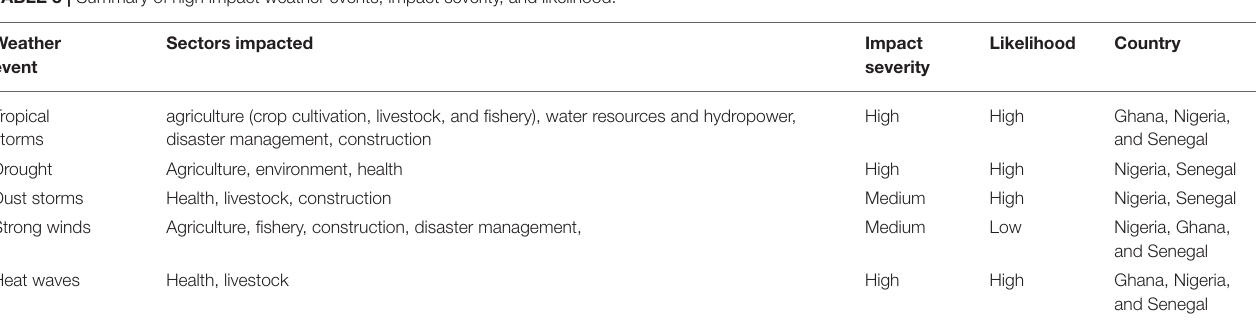
TABLE 3 | Summary of high impact weather events, impact severity, and likelihood.